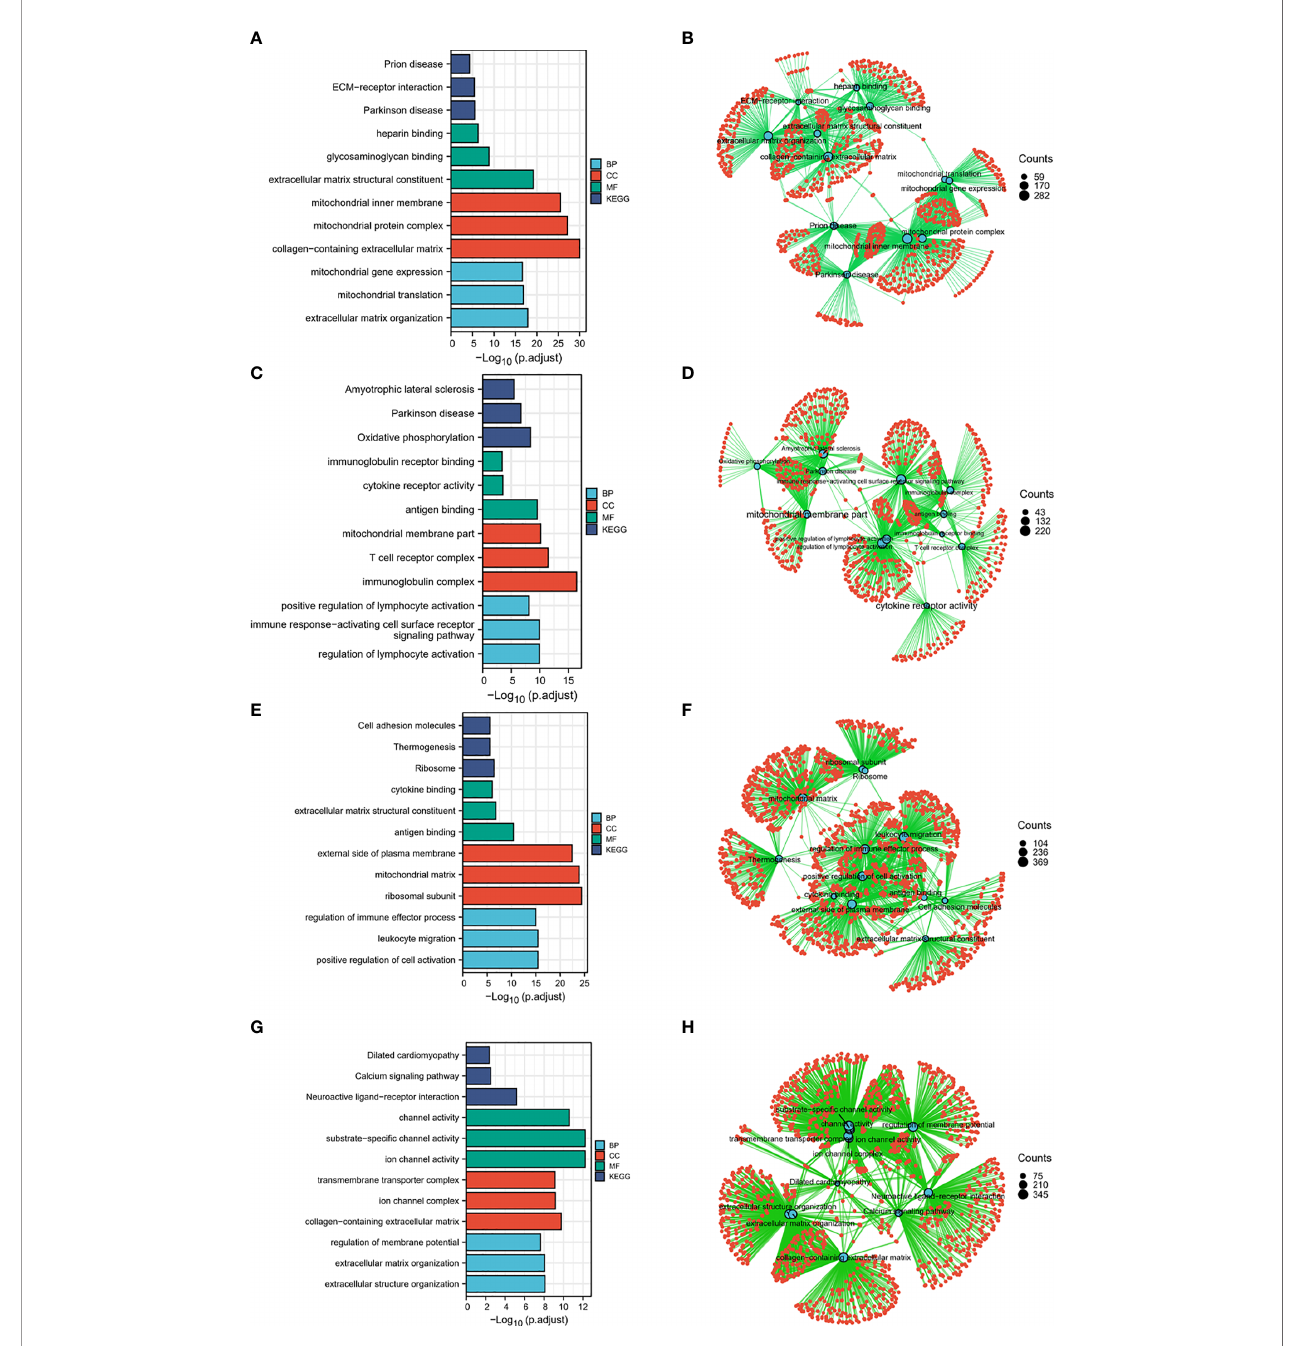
FIGURE 6 | HSPA1A-, HSPA1B-, HSPA7-, and HSPA9-related signaling pathways identi fi ed by gene ontology. (A) and (B) HSPA1A-related signaling pathways. (C) and (D) HSPA1B-related signaling pathways. (E) and (F) HSPA7-related signaling pathways. (G) and (H) HSPA9-related signaling